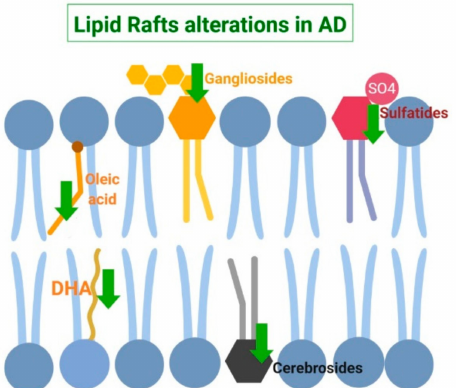
Figure 2. Schematic summary of lipid raft alterations in Alzheimer’s Disease (AD). In this pathologic state, both monounsaturated oleic acid (18:1) and polyunsaturated docosahexaenoic acid (DHA, (n-3 PUFA)) are depleted. Moreover, three member of the sphingolipids family are also reduced: gangliosides, cerebrosides, and